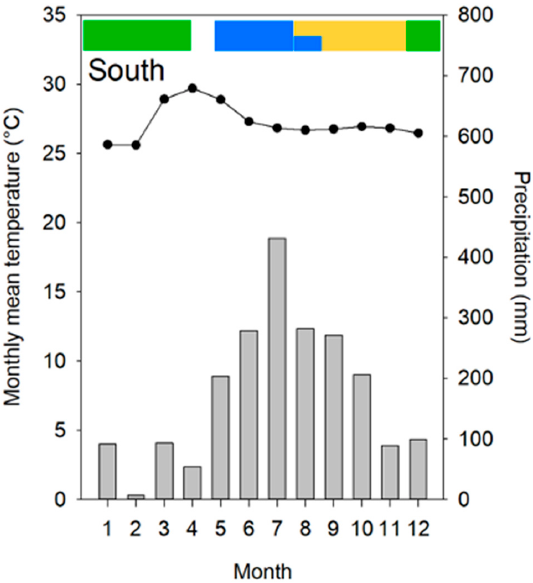
Figure 6. Time windows of cropping seasons in the Mekong River Delta (MRD) (E—green, M—blue, L—gold) shown with rainfall / temperature data (values from 2018 at Soc Trang).